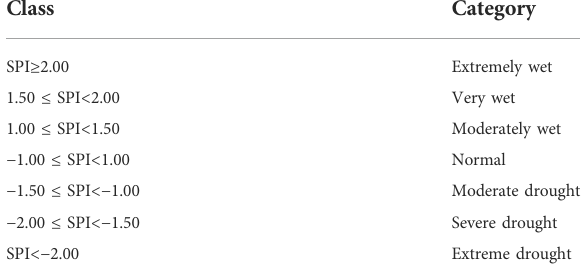
TABLE 2 Drought classi fi cation according to SPI values (Rousta et al., 2020a; Rousta et al.,